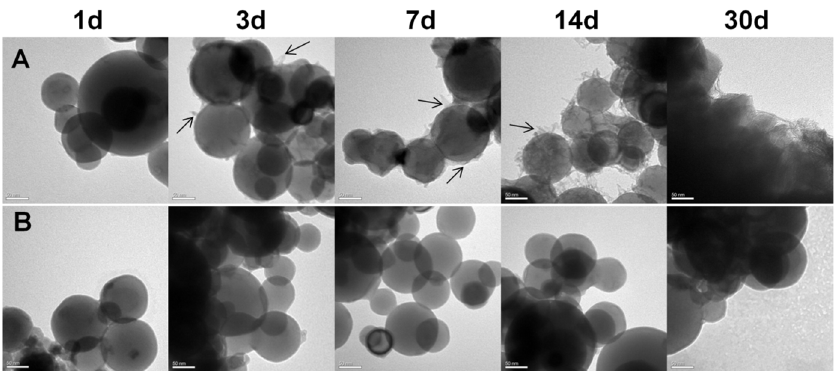
Figure 1. Investigation of oxidation of Al NPs dispersed in aqueous solution at room temperature. ( A ) TEM micrographs of Al NPs dispersed in ultrapure water. ( B ) TEM micrographs of Al NPs dispersed in phosphate buffer (PBS, 0.01 M, pH 7.0). Scale bars are 50 nm.